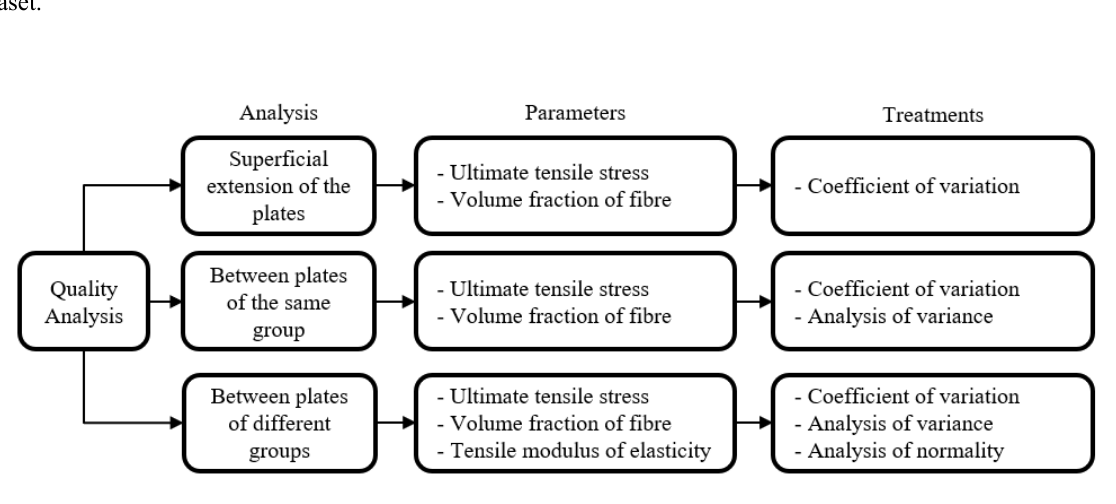
Samples in the form of 25 cm by 2.50 cm rectangles, with approximately 2.30 mm thickness, were used